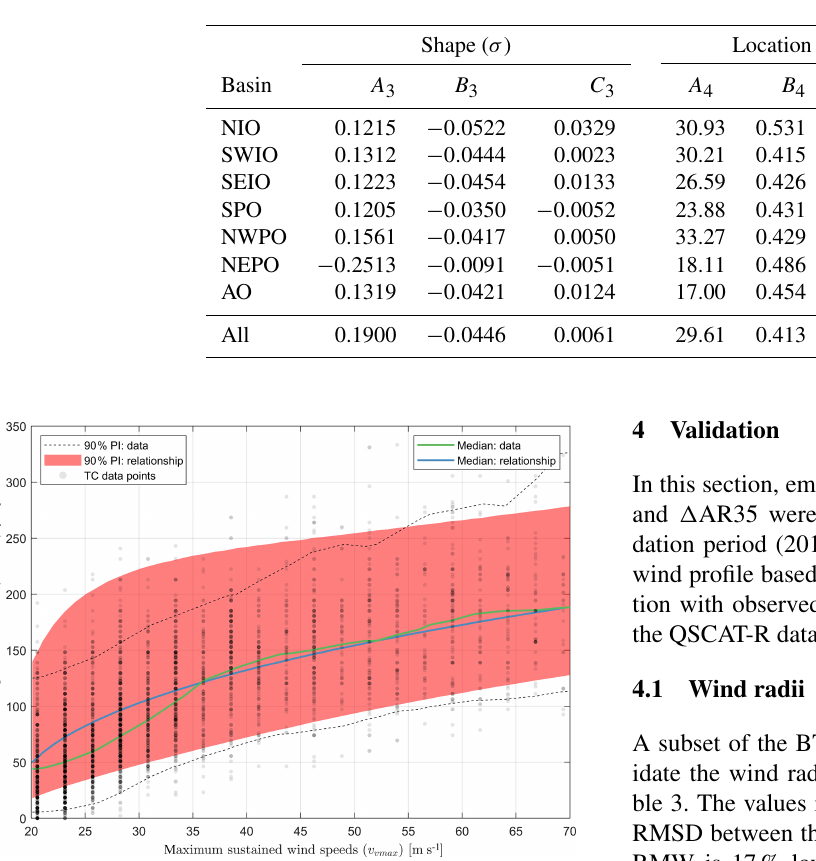
Table 2. Fitting coefficients for the lognormal (cid:49) AR35 as described in Eq. (4).